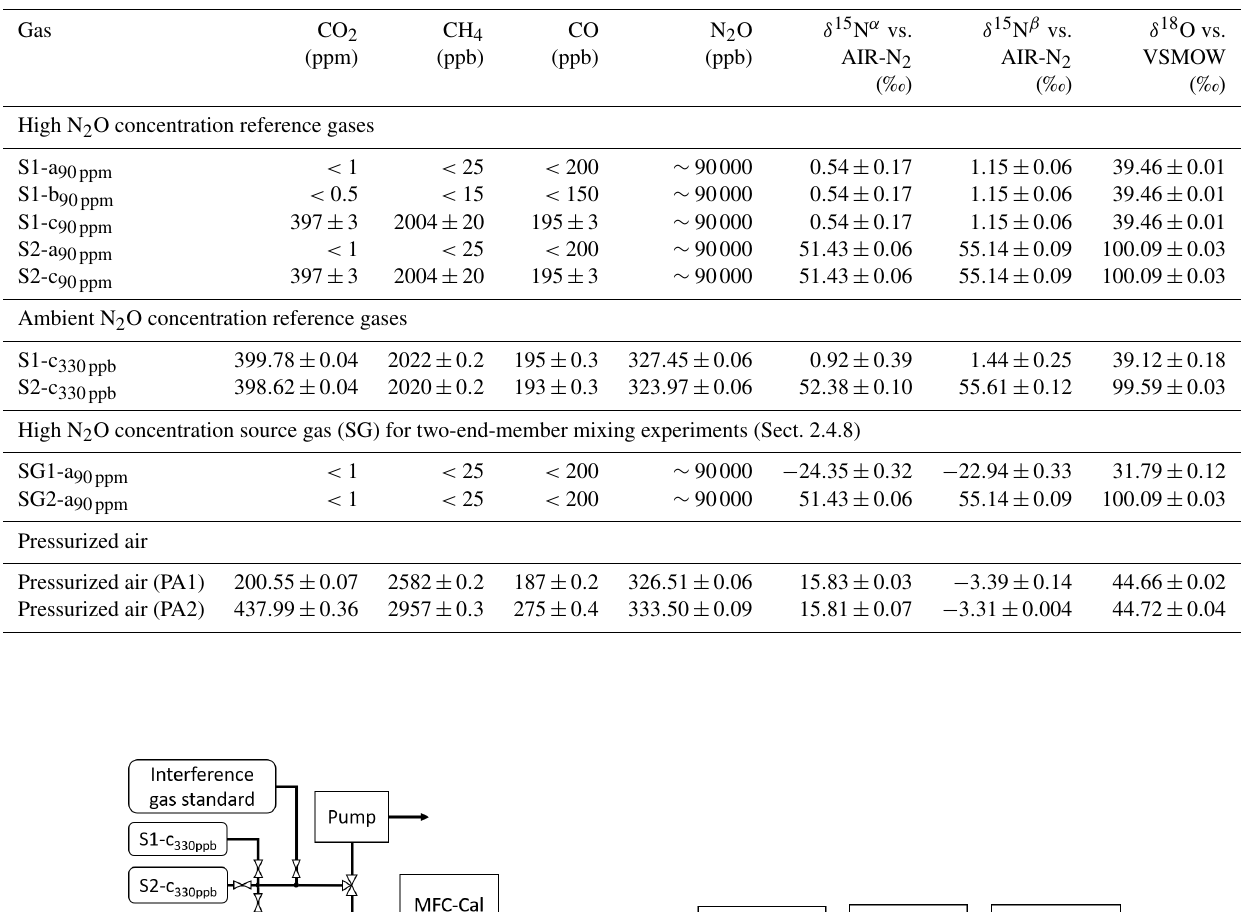
Table 3. Trace gas concentrations and N 2 O isotopic composition of high and ambient N 2 O concentration reference gases, and pressurized air. Trace gas concentrations of high concentration reference gases were retrieved from the composition of matrix gases used for their production (see Table 2); trace gas concentrations in ambient concentration reference gases and pressurized air were analyzed by WMO GAW WCC Empa against standards of the NOAA/ESRL/GMD. The N 2 O isotopic composition was quantified by laser spectroscopy (QCLAS) and